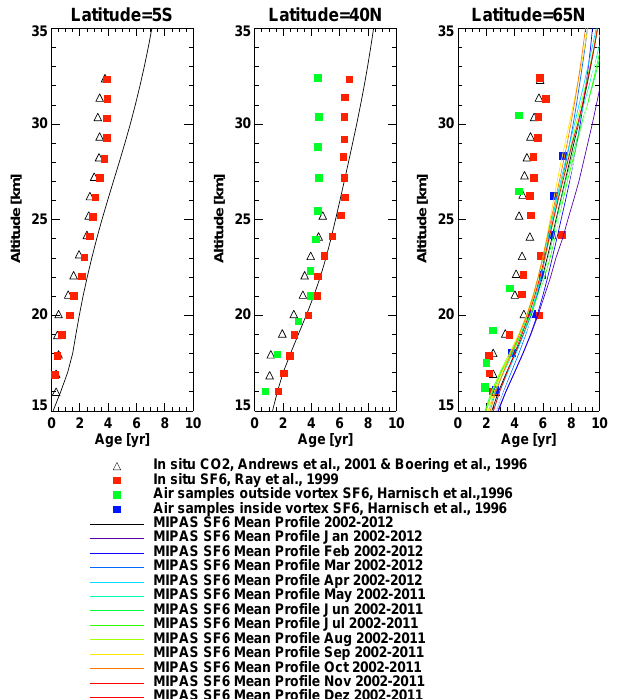
Figure 5. Comparison of MIPAS AoA profiles with airborne pro- files of the 1990s for the tropics (5 ◦ S), the northern midlatitudes (40 ◦ N) and the northern high latitudes (65 ◦